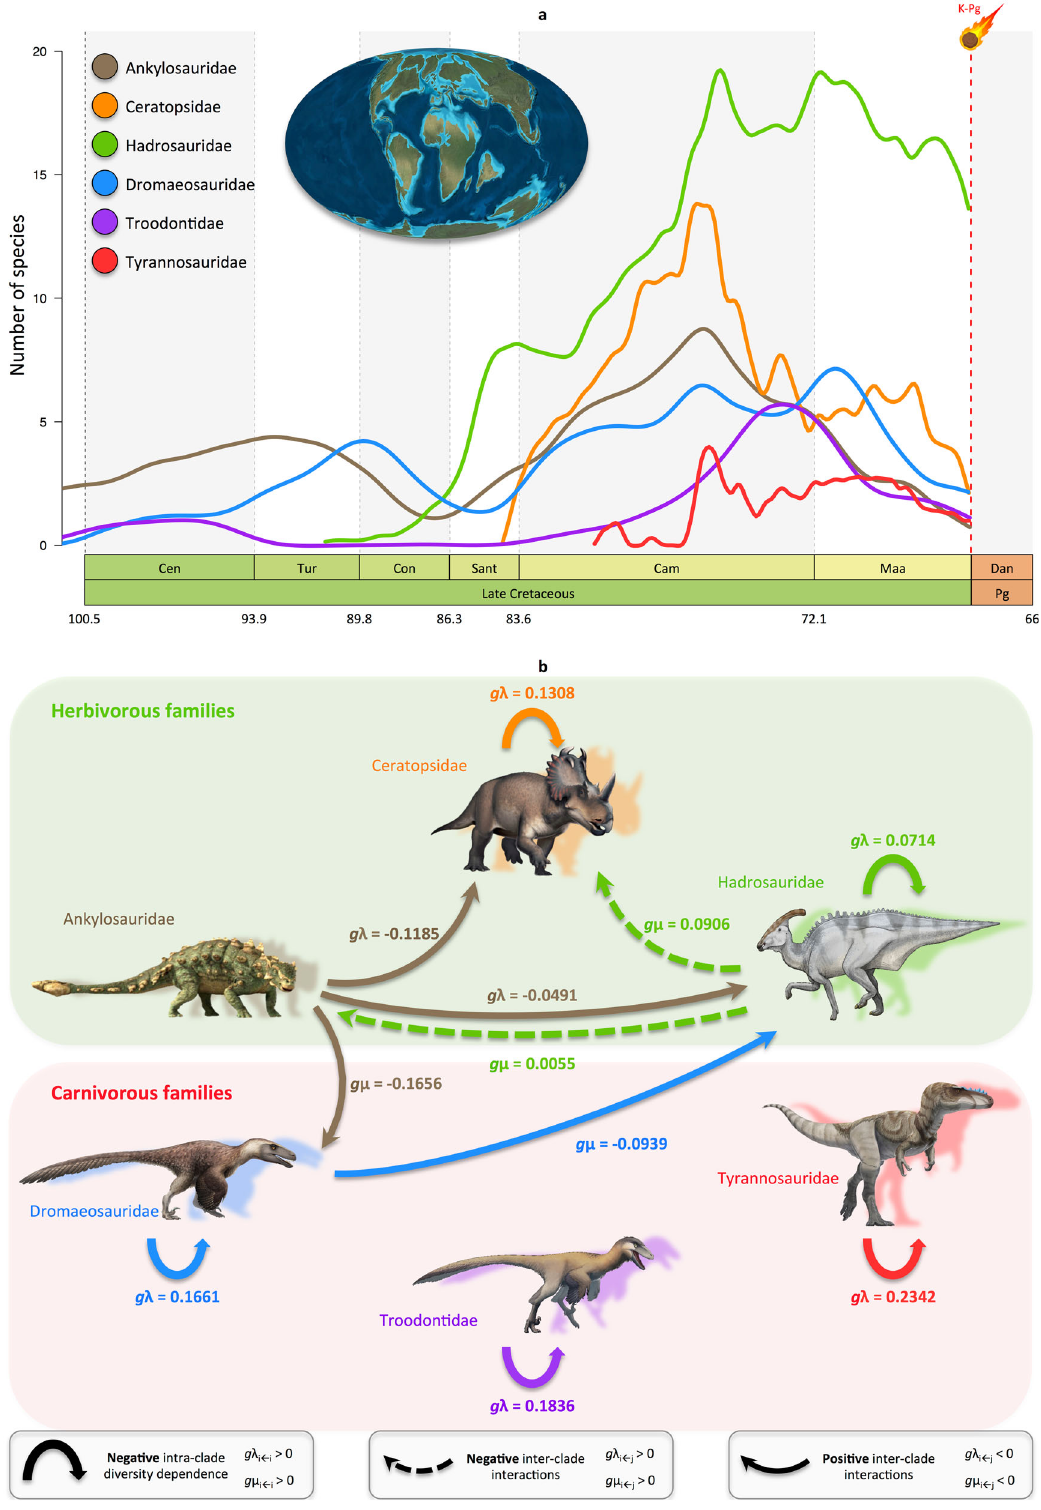
Fig. 5 Diversity trajectories and the effect of competition on diversi fi cation rates of dinosaur families. a Diversity trajectories of the three carnivorous and three herbivorous dinosaur families at global scale. Reconstructions of diversity trajectories are the mean of 10 replicates, incorporating uncertainties around the age of the fossil occurrences. b Network showing the diversity-dependent effects within and between clades on speciation and extinction rates (only signi fi cant correlations are shown, Supplementary Table 2). Each arrow indicates the type of interaction imposed by a given group over another, which quanti fi es the proportion of rate change (decrease/increase for speciation or extinction) associated with the addition of one species of the competing group. Analyses for the New World dinosaurs only are presented in Supplementary Fig. 12 (Supplementary Table 3). Abbreviations as in Fig. 1. Dinosaur pictures courtesy of Fred Wierum (© Wikimedia Commons), Debivort (© Wikimedia Commons), Jack Mayer Wood (© Wikimedia Commons): https://creativecommons.org/licenses/ by-sa/4.0/. Palaeomap used with permission © 2020 Colorado Plateau Geosystems Inc. Asteroid icon made by Fabien Condamine. NATURE COMMUNICATIONS| (2021) 12:3833